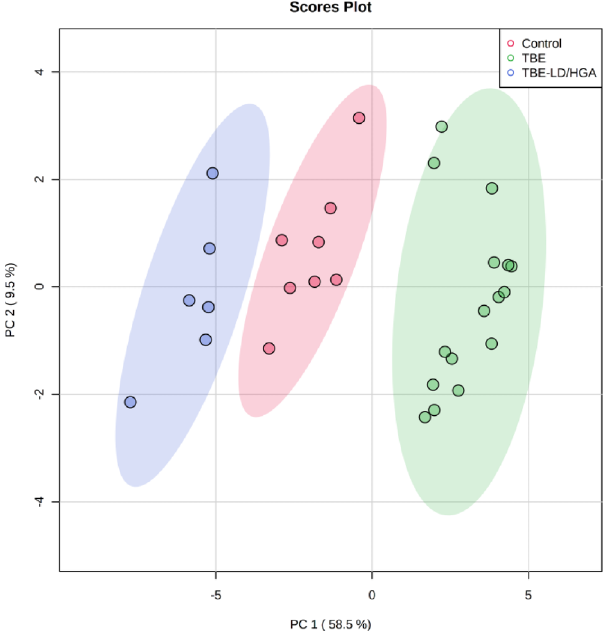
Figure 4. Two-dimensional principal component analysis (2D PCA) scores plot of the relative CER content in the plasma of healthy subjects (Control) and TBE patients (TBE) and TBE patients with co-infections (TBE + LD/HGA).